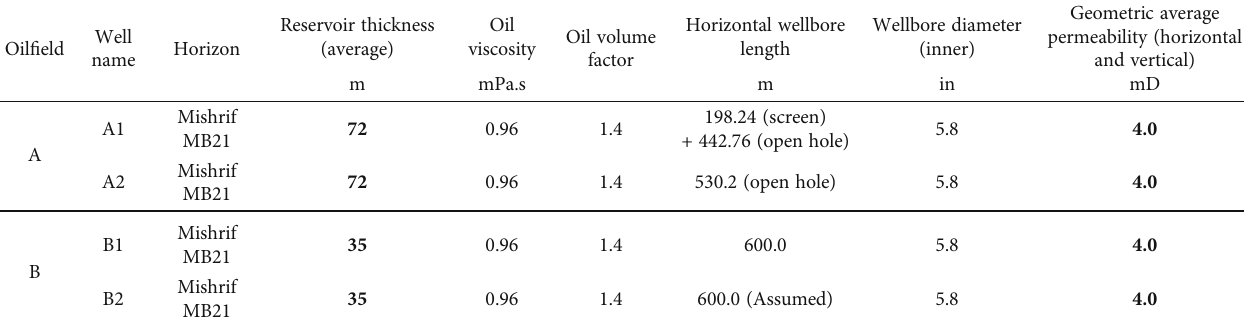
Table 3: Well completion and fl uid property parameters of two horizontal